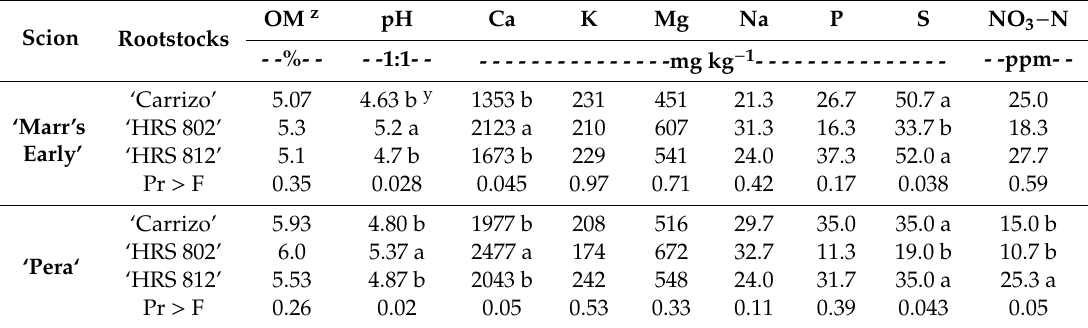
Table 1. Soil Nutrients in 2016 of two sweet orange cultivars growing on Alonso Clay series soil grafted on three di ff erent rootstocks at the Agricultural Experiment Station of Adjuntas, Puerto Rico. Scion